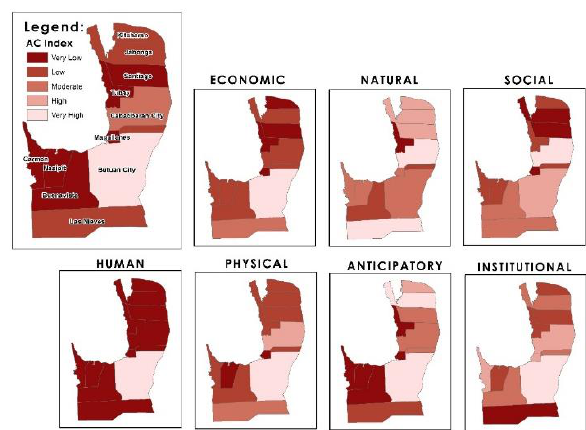
Figure 5. Adaptive Capacity index in Agusan del